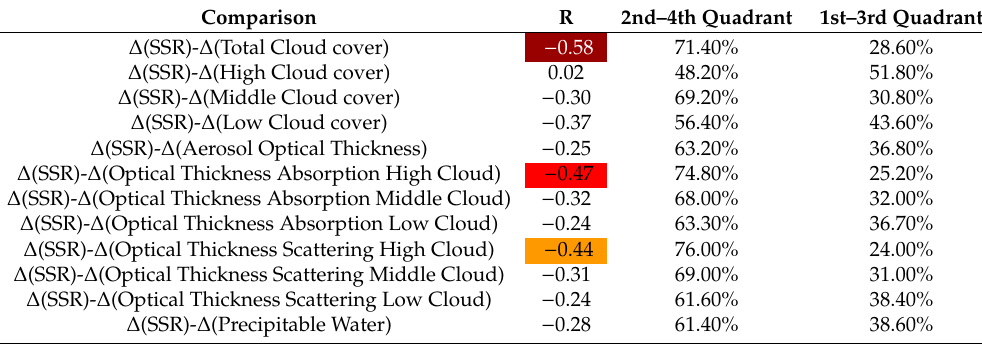
Figure 5. Contribution of changes in total cloud cover ( a ) and changes in aerosol optical thickness ( b ) to the model-computed changes of downward surface solar radiation ( ∆ SSR) over the period 2001–2009 (Figure 1). The contribution is expressed in relative percent (%) terms with respect to ( ∆ SSR). Table 1. Correlation coe ffi cient (R) between changes in the main physical parameters, ∆ (V), and changes in downward surface solar radiation, ∆ (SSR). The R values are computed for matched ∆ (V) and ∆ (SSR) geographical cell data pairs all over the globe. The percentages of the total number of matched data pairs lying in the 2nd and 4th quadrants (indicating physical agreement between changes of parameters and SSR) and in the 1st and 3rd quadrants (physical disagreement) are also given in the third and fourth column of the table. Colored cells indicate the three parameters having the strongest correlation with ∆ (SSR). The brown color indicates the strongest, the red color indicates the second strongest, and the orange color indicates the third strongest correlation coe ffi cients between ∆ (V) and ∆